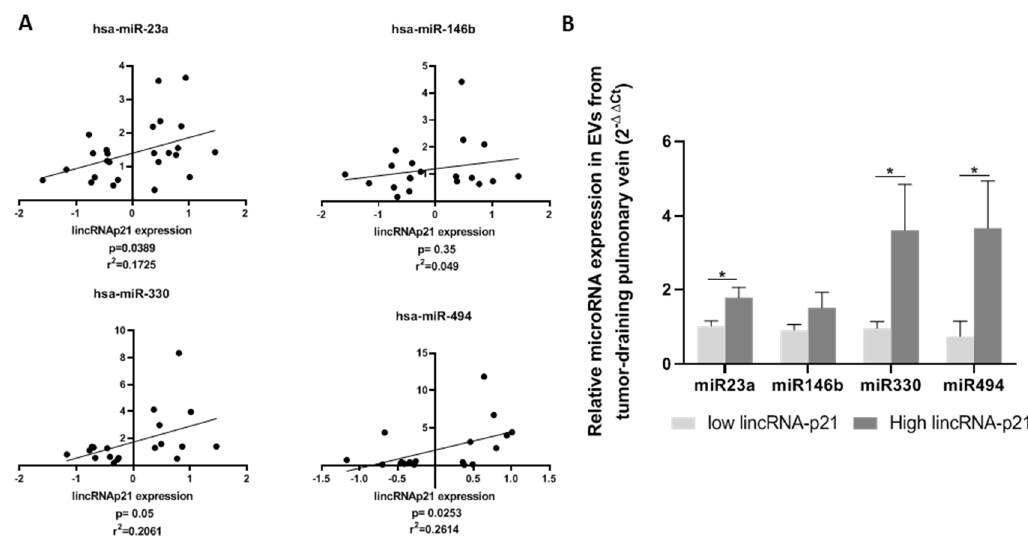
Figure 4. ( A ) Positive correlation between the expression of lincRNA-p21 and microRNAs miR-23a, miR-146b, miR-330, and miR-494. ( B ) EV expression levels of miR-23a, miR-146b, miR-330, and miR-494 in patient samples according to lincRNA-p21 expression levels.